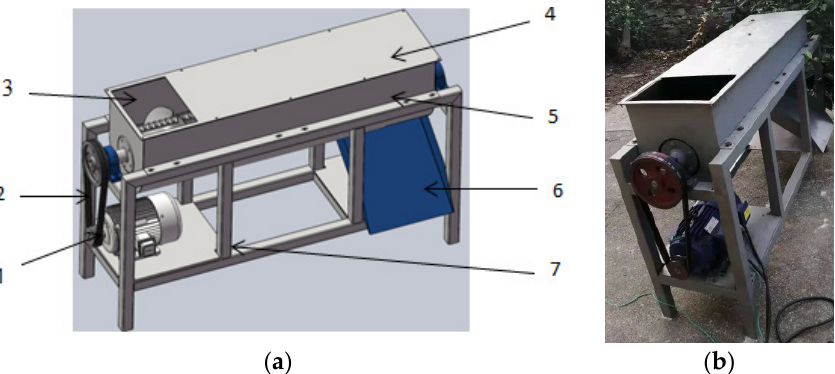
Figure 1. Designed model ( a ) and prototype ( b ) of the sunflower threshing machine, consisting of the following functional parts: the power source (1), power transmission system (2), feed opening (3), cover (4), threshing box (5), output opening and tray (6) and thresher frame